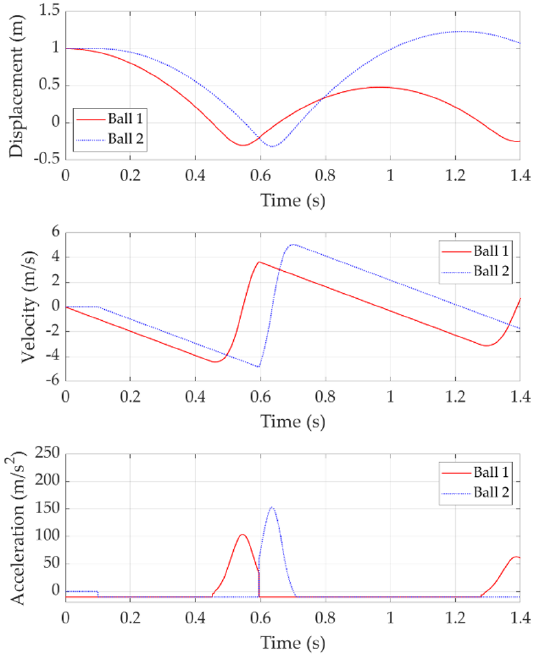
Figure 8. Double bounce with 0.1s release time